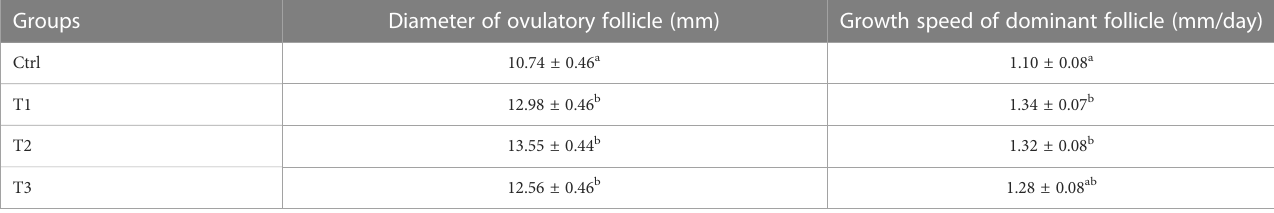
FIGURE 4 The effects of AMH-INH-RFRP DNA vaccine on steroid hormones and cytokines in buffalo after nasal immunization. (A-D) represent the effect on P4, E2, IFN- g , and IL-4, respectively. (E) The effect of antibody-positive and antibody-negative buffaloes on P4, E2, IL-4 and IFN- g . Data are presented as mean ± SEM. The bars with difference letters indicated signi fi cant differences ( a,b P < 0.05; A,B P <